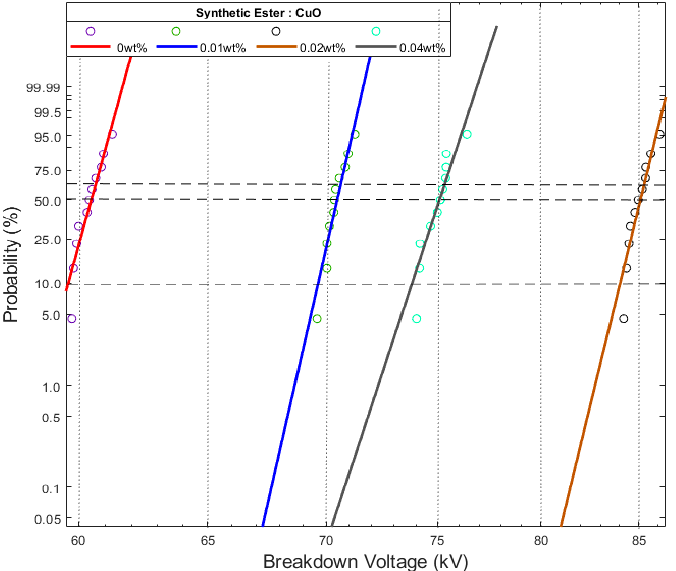
Figure 10. Plot of Probability distribution Vs. Breakdown voltage for CuO nanofluids and pure oil.